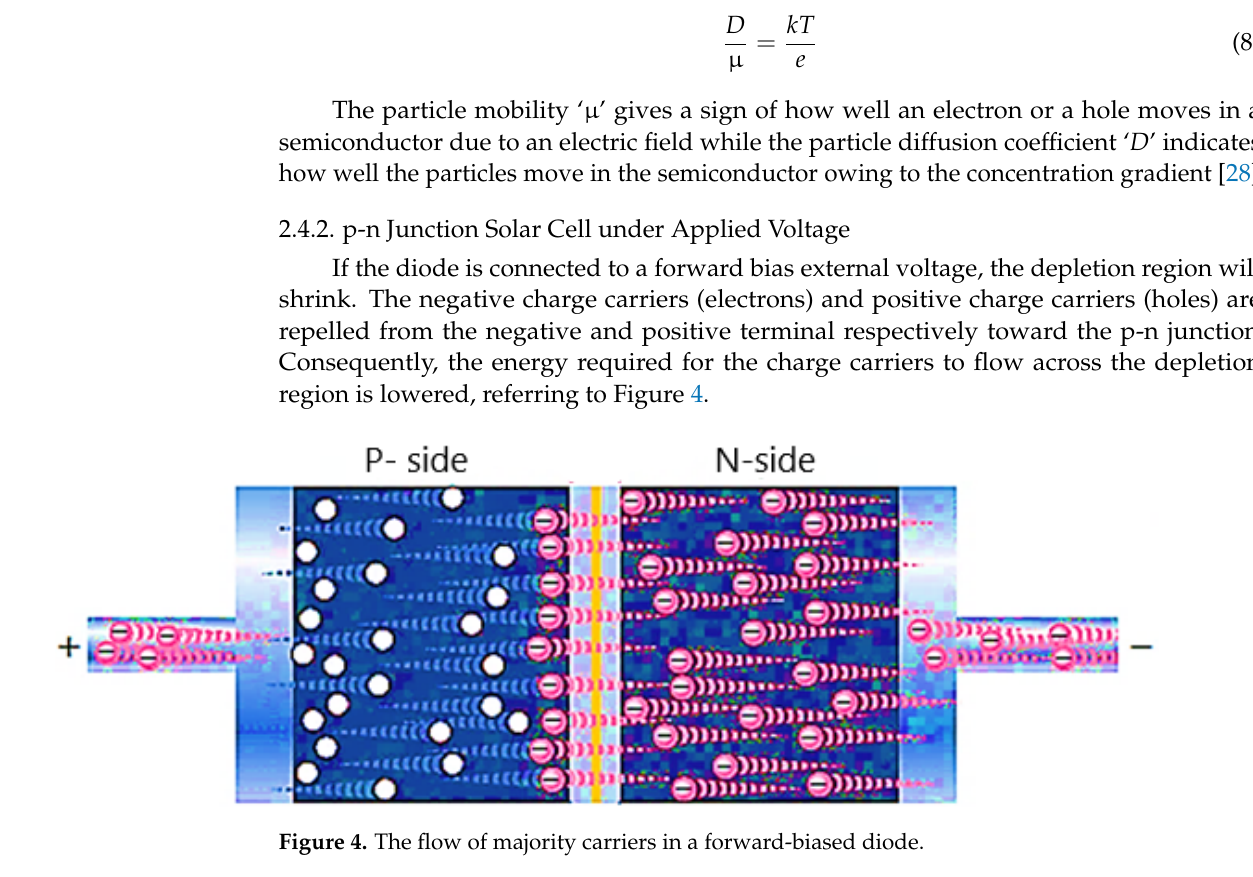
Figure 5. The PV cell under illumination.